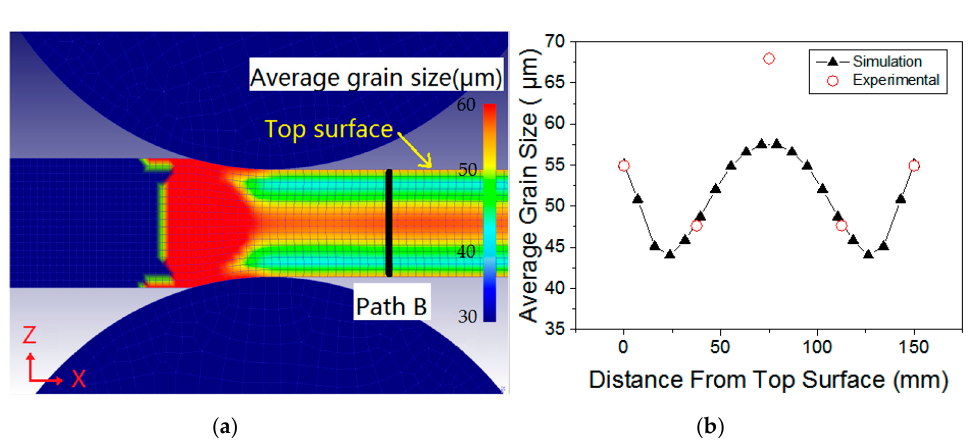
Figure 4. Distribution of average grain size in thickness direction of hot rolled plate. ( a ) FEM model of thick plate hot rolling; ( b ) distribution of average grain size.